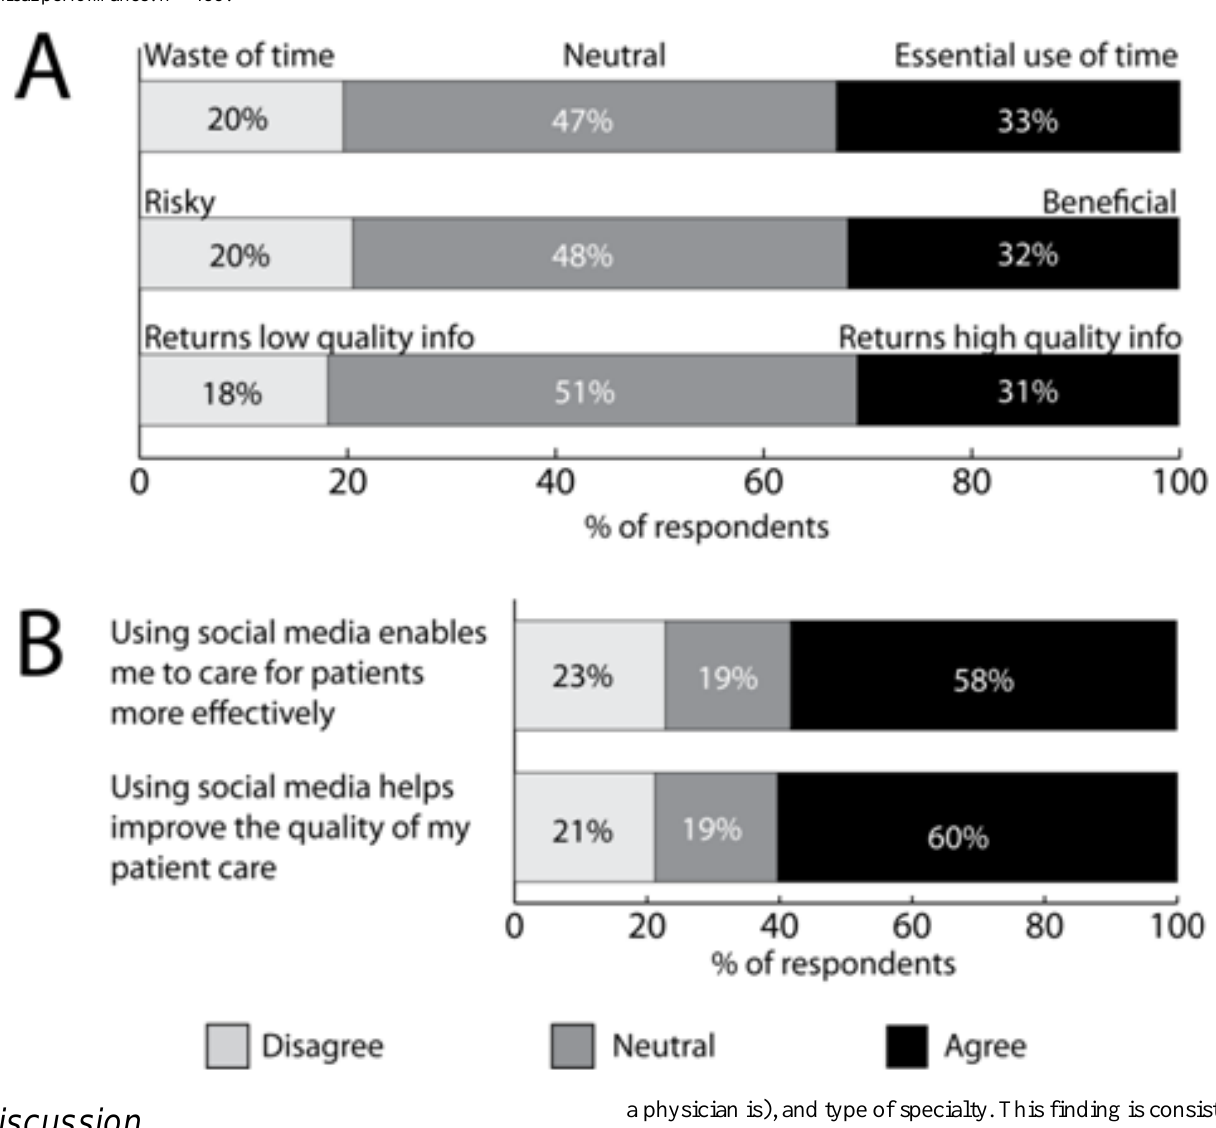
Figure 4. Respondents expressed how they felt about the use of social media along 3 dimensions: perceived risk, perceived usefulness, and perceived quality of information (part A). Part B shows how respondents perceived their engagement and use of social media to affect their competency and clinical performance. n =